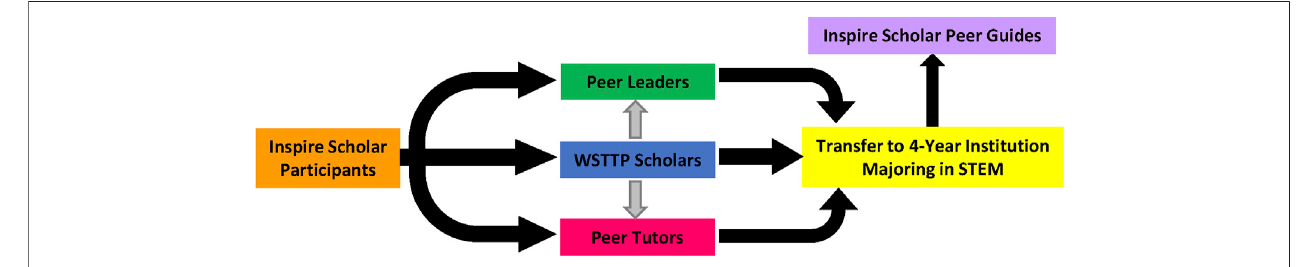
FIGURE 1 | Tiered participation model in the Madison College LSAMP Inspire Scholars Program.